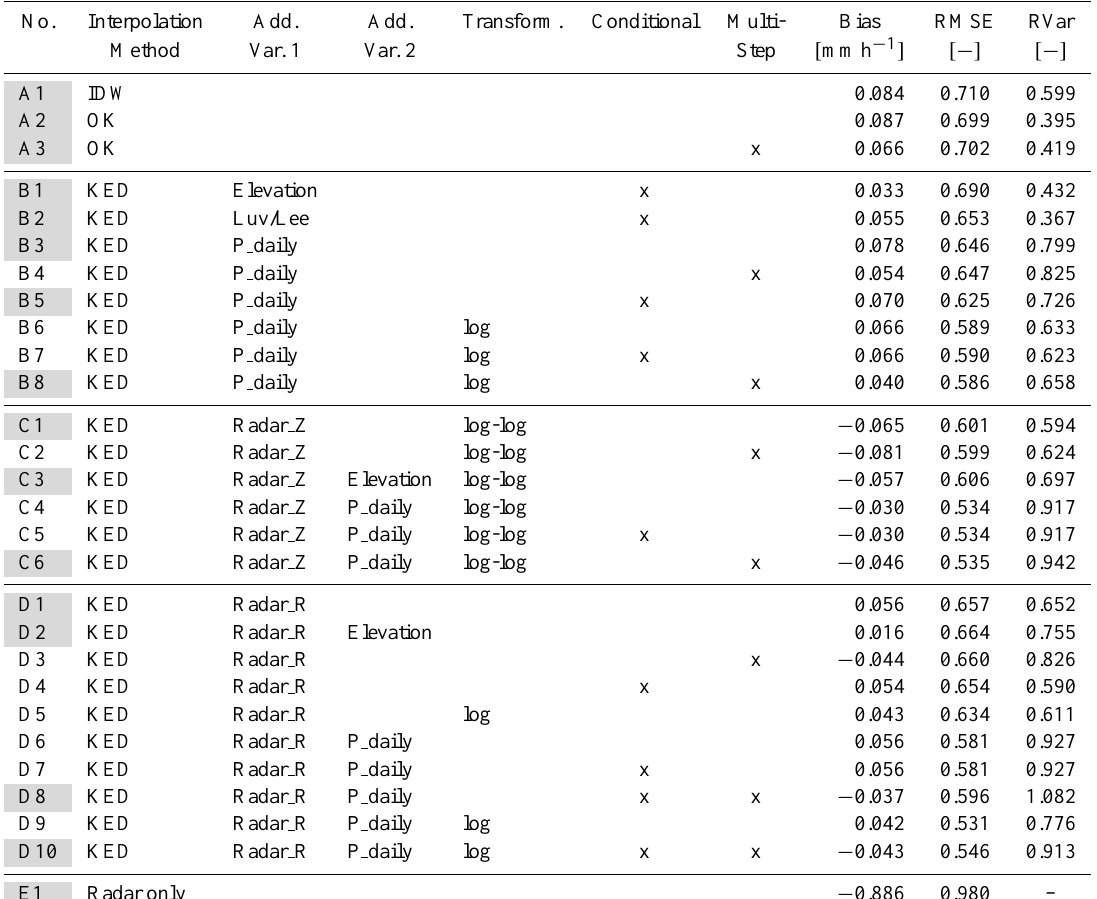
Table 6. Precipitation cross-validation results using all winter events averaged over time steps with an average precipitation exceeding a threshold of 1mmh − 1 (“log”: all Y k are log-transformed, “log-log”: both Z and all Y k are log-transformed highlighted no. are presented in Fig.